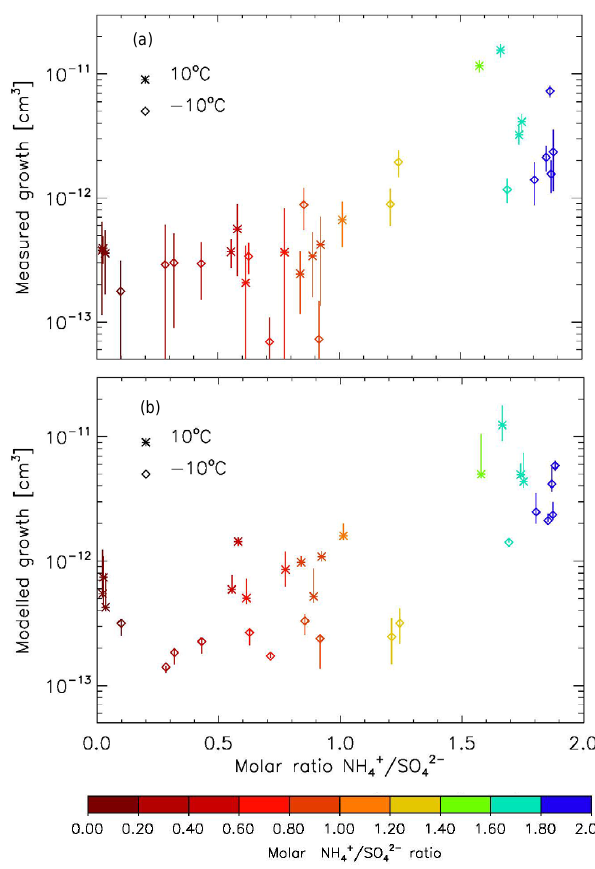
Figure 10. (a) The measured growth in the total aerosol volume / SO 2 − as a function of NH + ratio in the seed aerosol, at 10 and 4 4 − 10 ◦ C. The growth is determined as the difference in aerosol vol- ume before and after the cloud. The error bars on the measured growth stem from the uncertainty in diameter in the SMPS mea- surements (which translates to approximately 14% in volume for particles with a diameter greater than 50nm and 22% for those with a diameter less than 50nm). (b) As in (a) , except here the modelled data are presented. The error bars stem from simulations carried out using the high and low limits of the dew point, as determined from the SIMONE